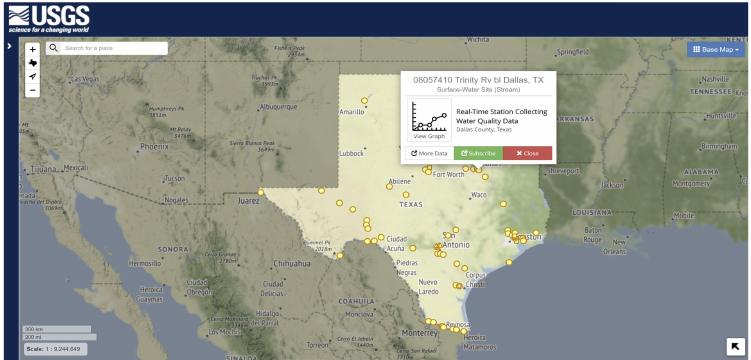
Figure 3. Water Quality Data Collection Sites of USGS -Texas.